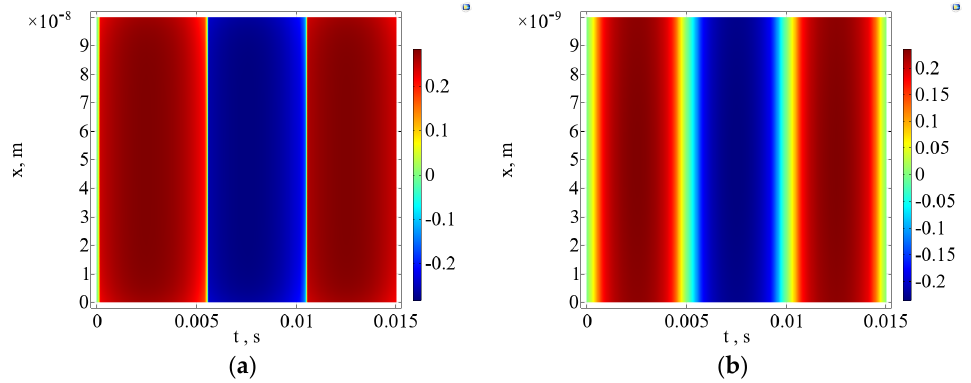
Figure 4. The space–time distributions of polarization in BaTiO 3 films computed at ( a ) l = 0.1 µ m and